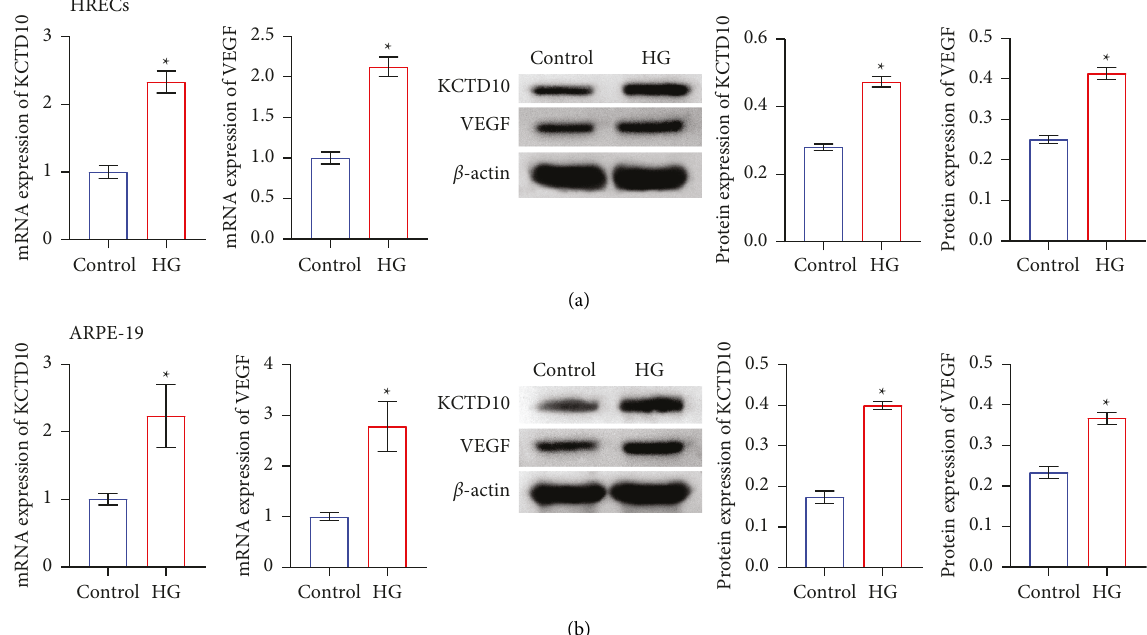
Figure 1: Expression of KCTD10 and VEGF in DR cells. (a) KCTD10 and VEGF expression in HRECs was identified by RT-qPCR and western blot. (b) KCTD10 and VEGF levels in ARPE-19 were determined by RT-qPCR and Western blot. ∗ P < 0 . 05 versus the control